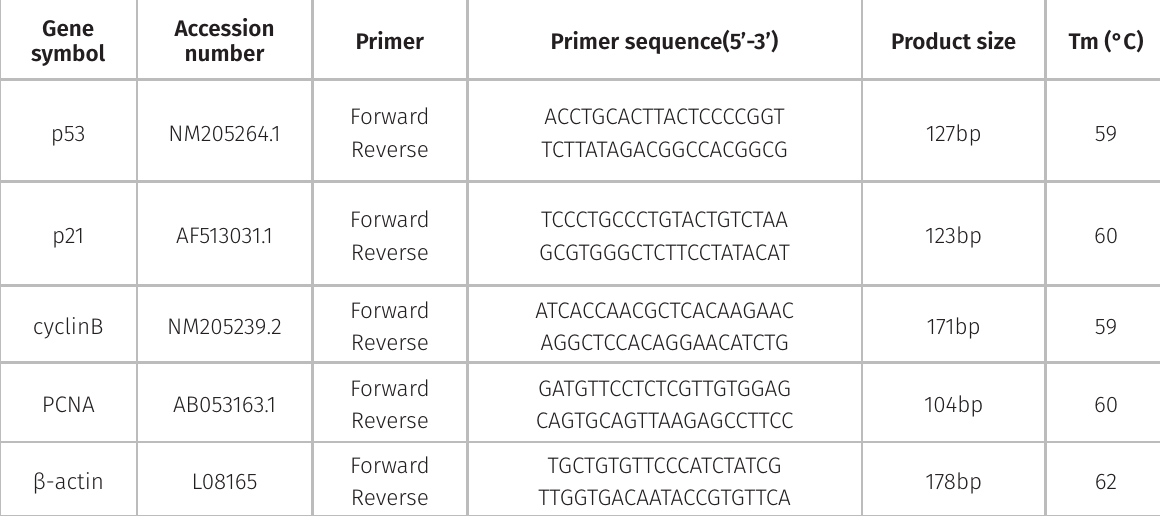
Table I. Sequence of primers used in qRT-PCR. Gene